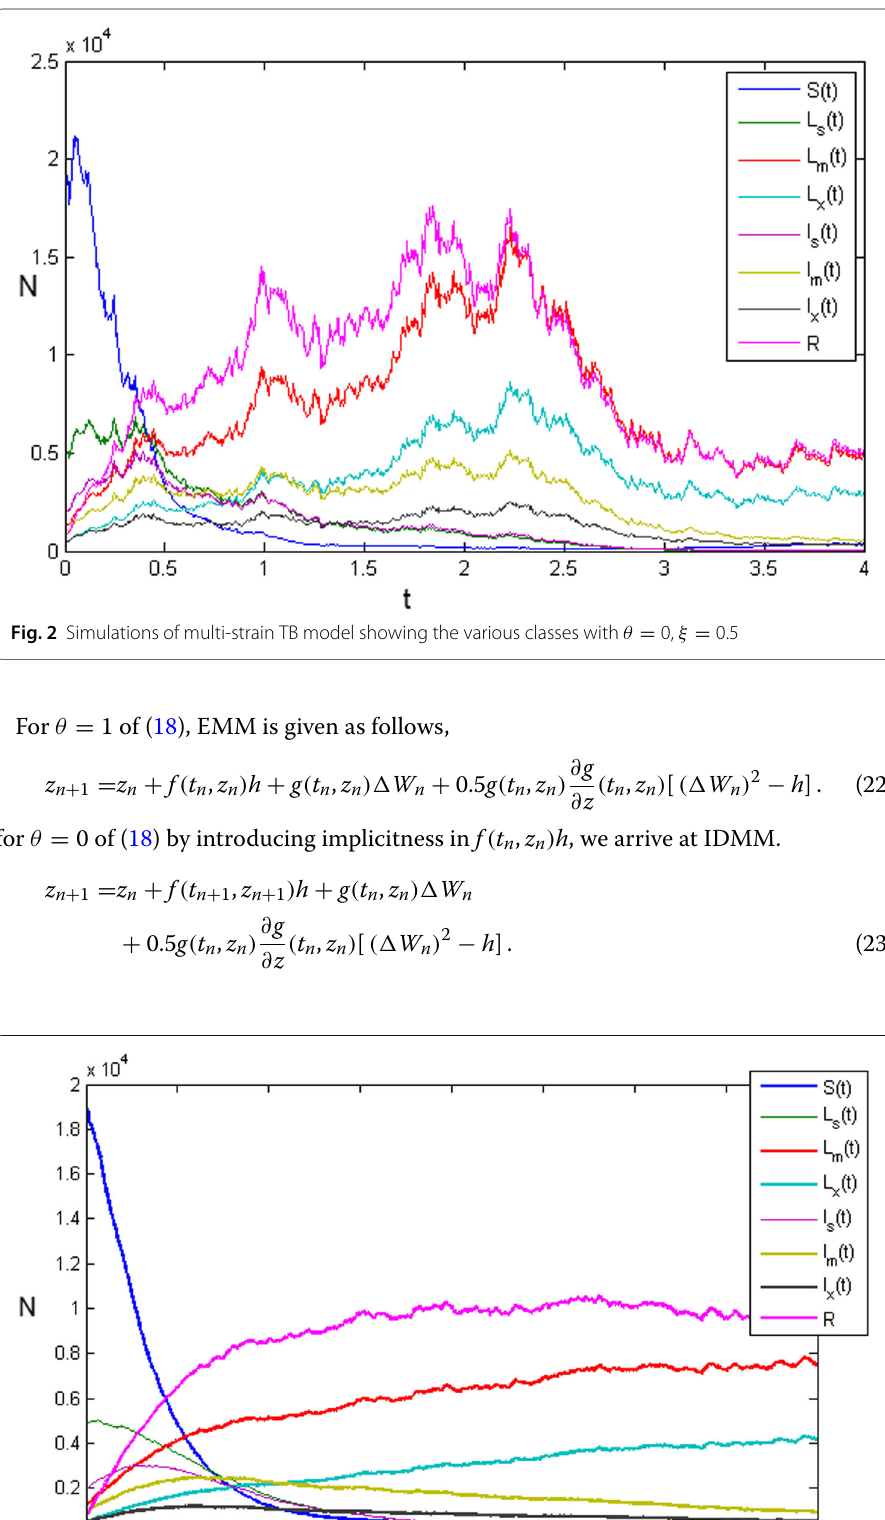
Fig. 3 Simulations of multi-strain TB model showing the various classes with θ = 0, ξ =